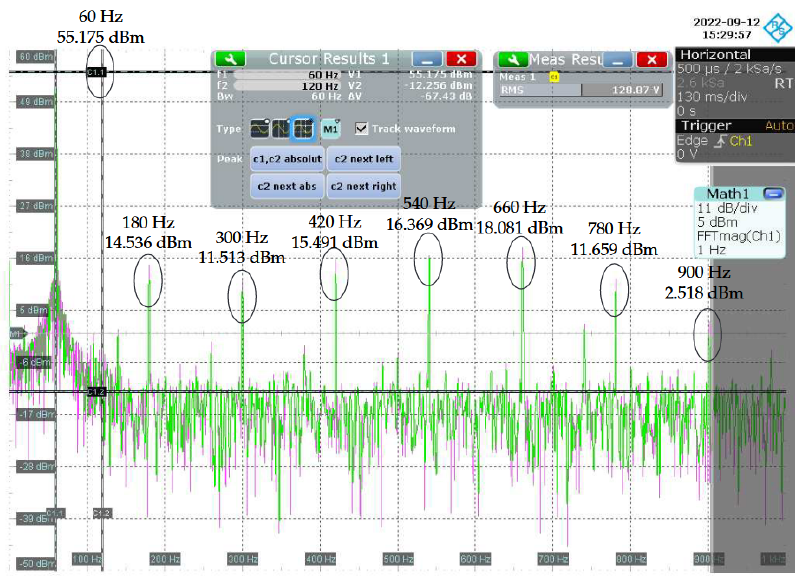
Figure 13. Magnitude spectrum of the voltage signal at the input of the NB-PLC notch coupling